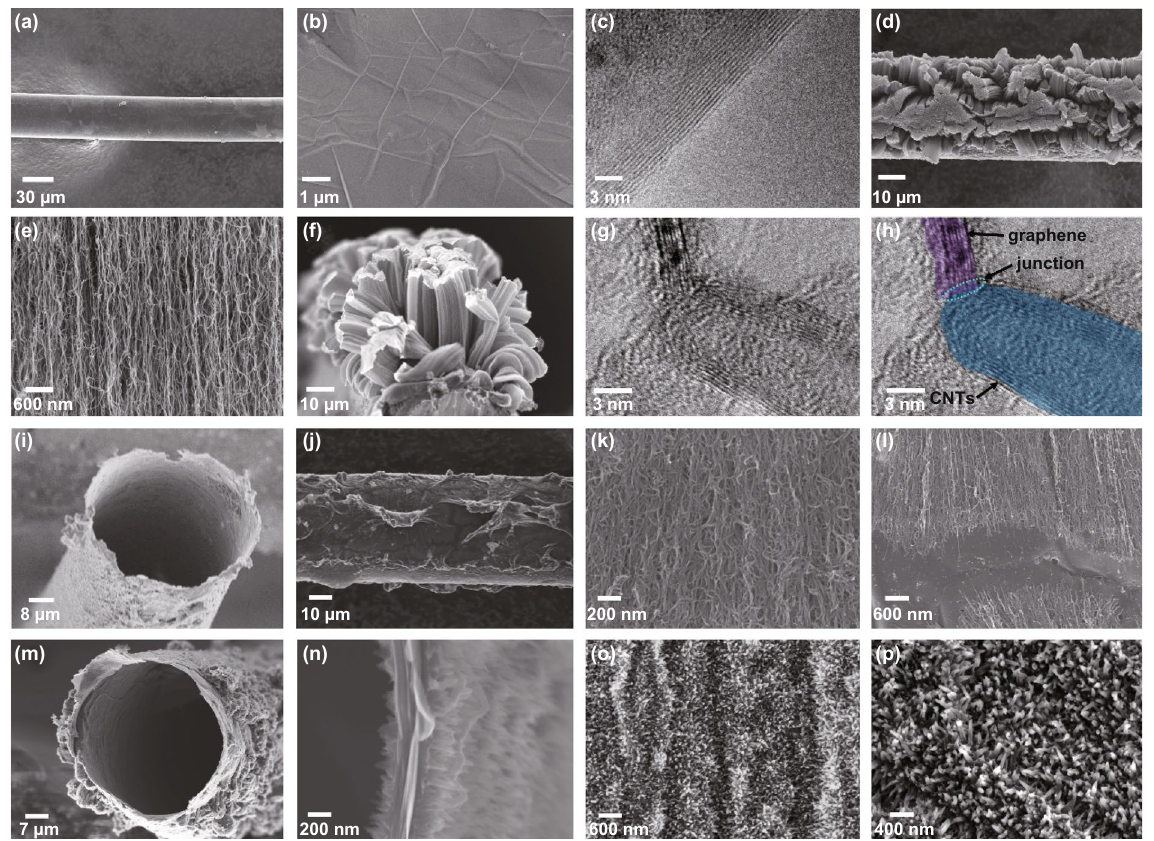
Fig. 2 Structure of G/CNTs hollow fiber and its composite fiber. a, b SEM images of the as-grown graphene on a Ni wire. c TEM image of graphene with eight to ten layers. d, e SEM images of CNTs array grown from graphene layer on Ni wire. f Cross-sectional SEM image of G/ CNTs on nickel wire. g, h TEM images of G/CNTs with a seamless connection. i Cross-sectional SEM image of the tubular structure of G/CNTs hollow fiber. j, k SEM images of G/CNTs hollow fiber from side view. l SEM image of the connected area of graphene and CNTs in G/CNTs hollow fiber. m, n SEM images of G/CNTs/PANI hollow fiber from cross-sectional view. o SEM image of PANI nanowire array grown on the external surface of G/CNTs fiber. p High-resolution SEM image of PANI nanowire array inside the tubular of G/CNTs